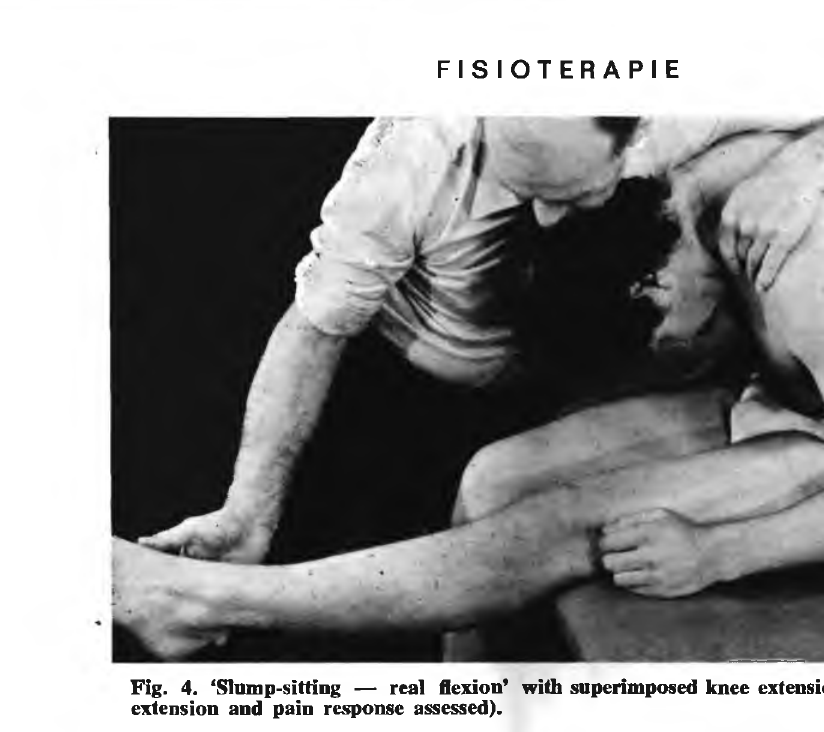
Fig. 4. ‘Slump-sitting — real flexion’ with superimposed knee extension (range of knee extension and pain response assessed).